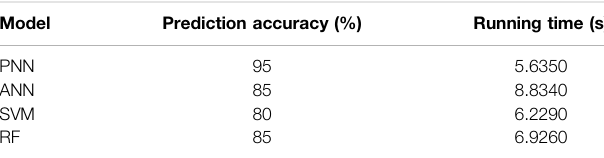
TABLE 9 | Performance evaluation of different prediction